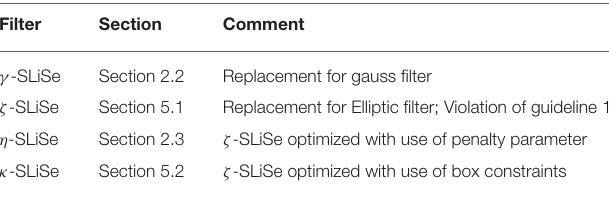
TABLE 3 | Overview of SLiSe-filters, the section in which each filter is introduced, and a short comment for each filter.